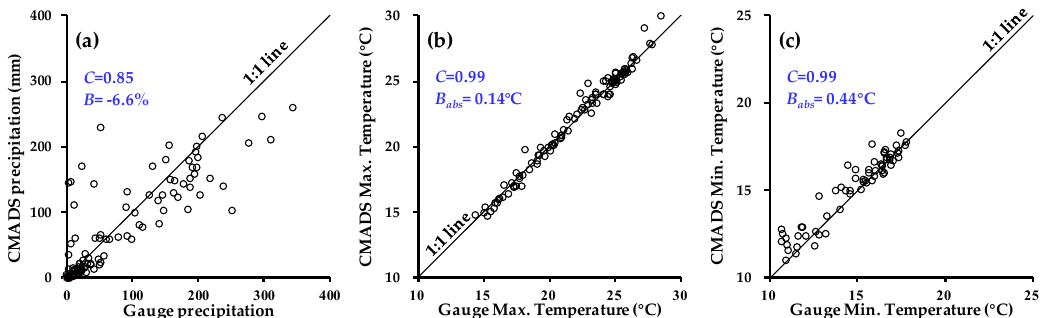
Figure 6. Scatter plots of the monthly CMADS reanalysis data and gauge observations: ( a ) Precipitation; ( b ) Maximum temperature; ( c ) Minimum temperature.